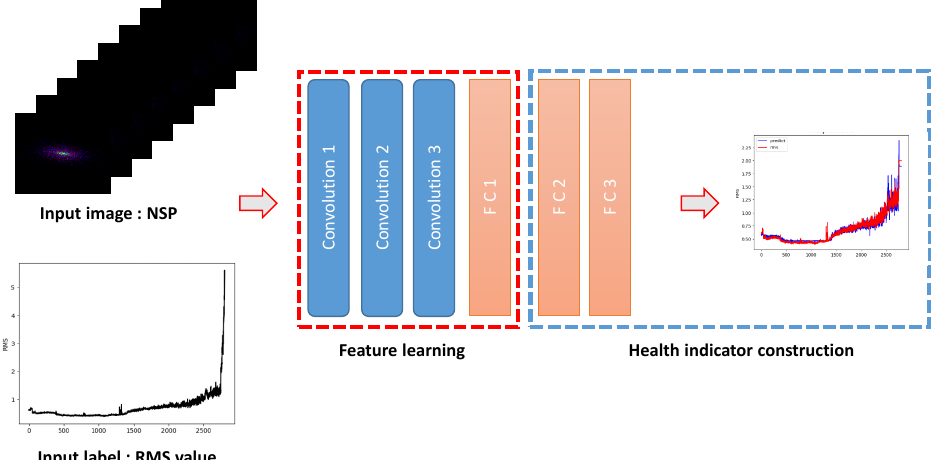
Figure 13. The RMS prediction model using NSP and